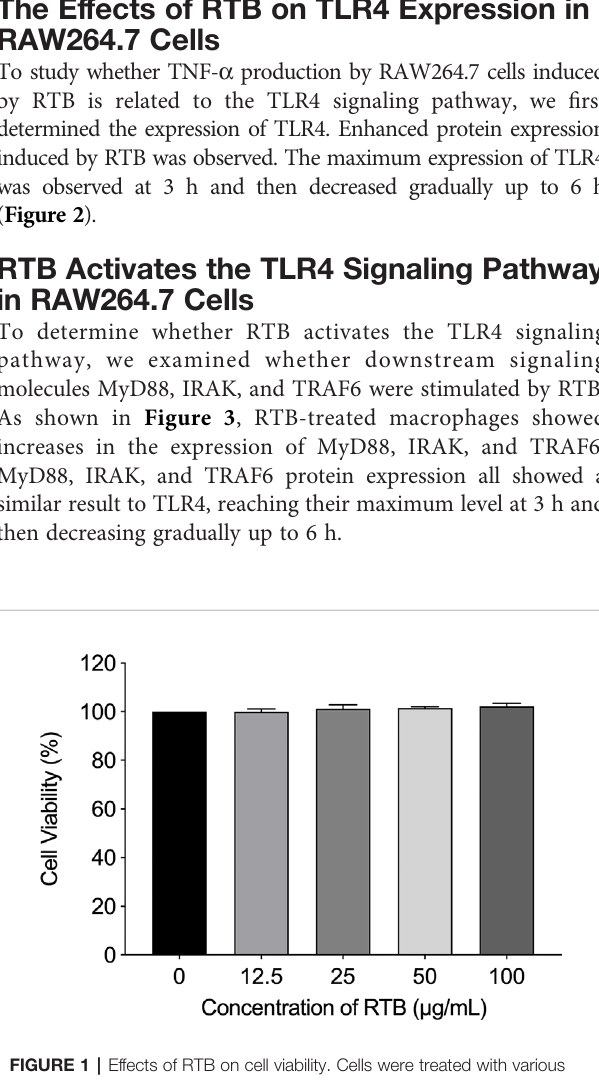
FIGURE 1 | Effects of RTB on cell viability. Cells were treated with various concentrations of RTB for 24 h. Cell proliferation was analyzed by Alamar Blue assay. Cell viability without RTB treatment (control) was taken as 100%. Data represent the mean ± SD from three representative